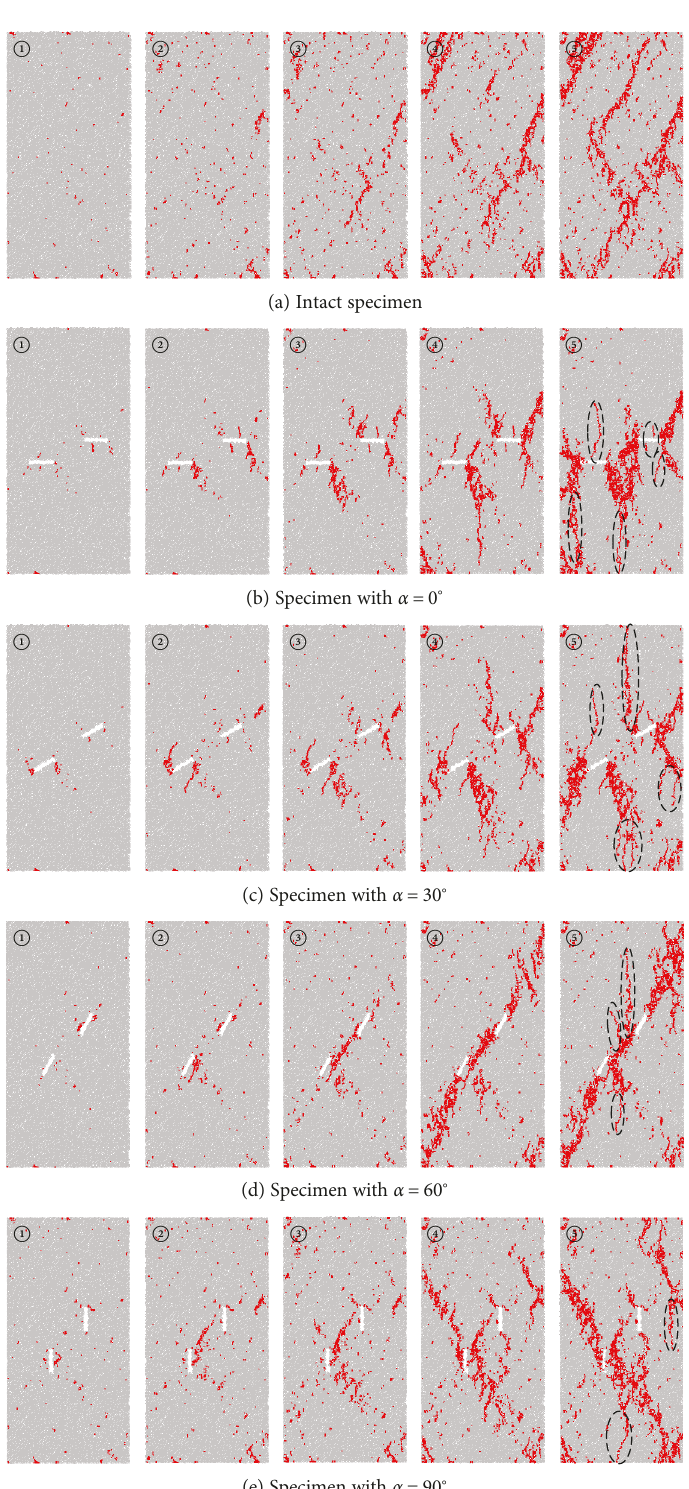
Figure 14: Cracking process of specimens under unloading condition (the red short lines in numerical specimens represent